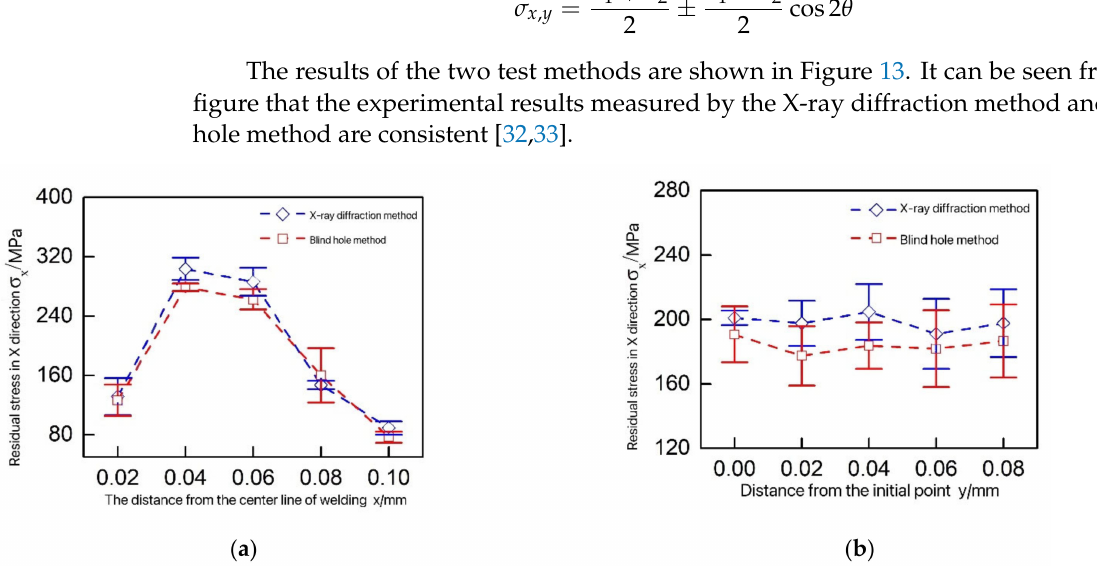
Figure 13. Comparison of test results: ( a ) stress distribution perpendicular to the weld and ( b ) stress distribution parallel to the